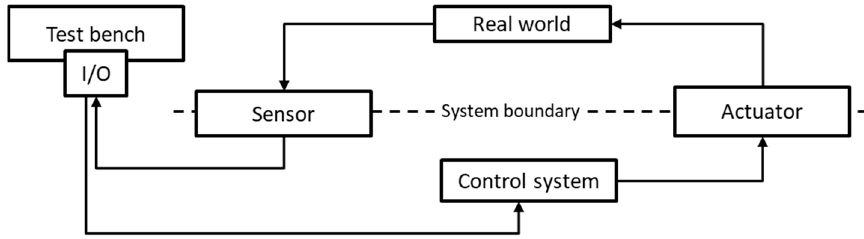
Figure 6. Real-time circuit extended by the test bench: schematic representation.